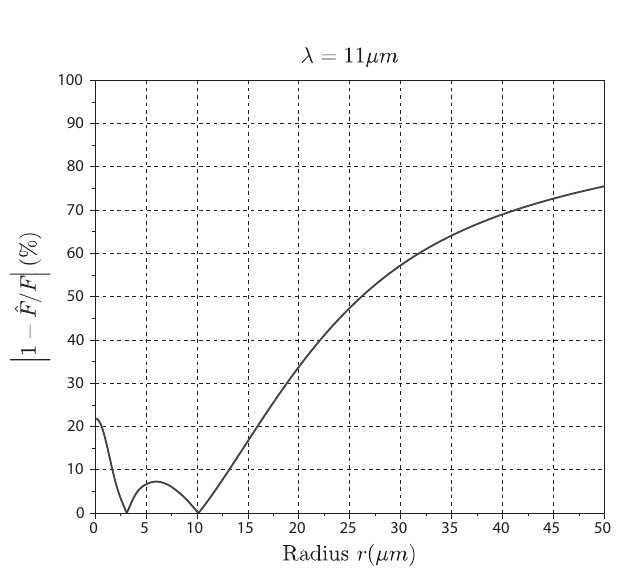
Fig. 7. Relative difference %) for λ = 4µm.